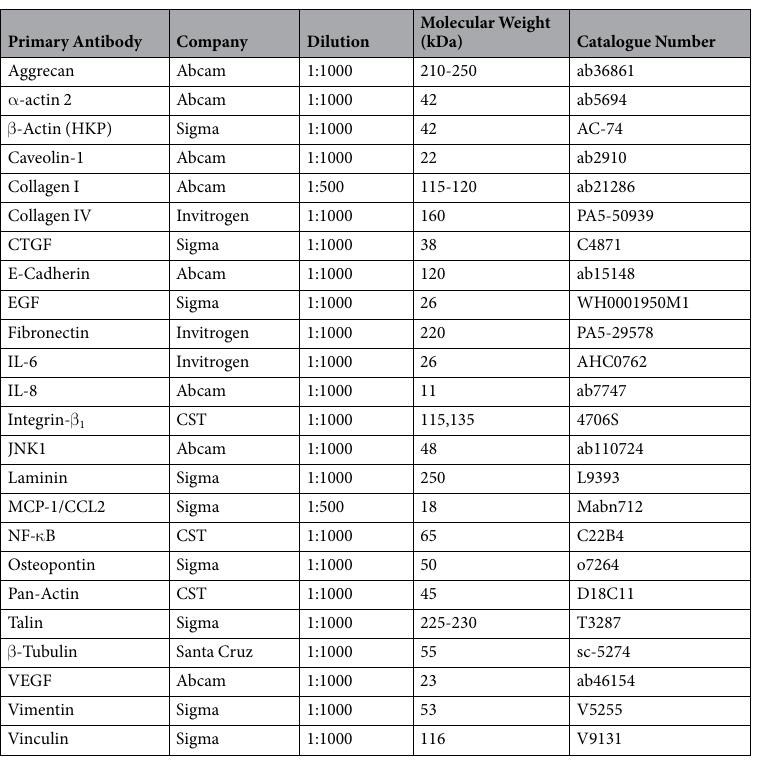
Table 5. Antibodies applied for Western blot analysis. The corresponding secondary antibody HRP-linked anti-mouse IgG (Ref. P0260) was used at a dilution of 1:2000, the HRP-linked anti-rabbit IgG (Ref. P0399, both Dako, Carpinteria, CA, USA) was used at a dilution of